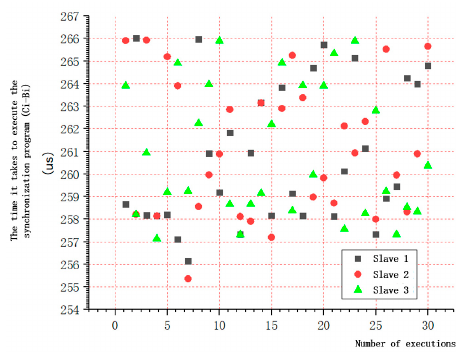
Figure 15. The results of the time required for single slave to execute synchronous code.